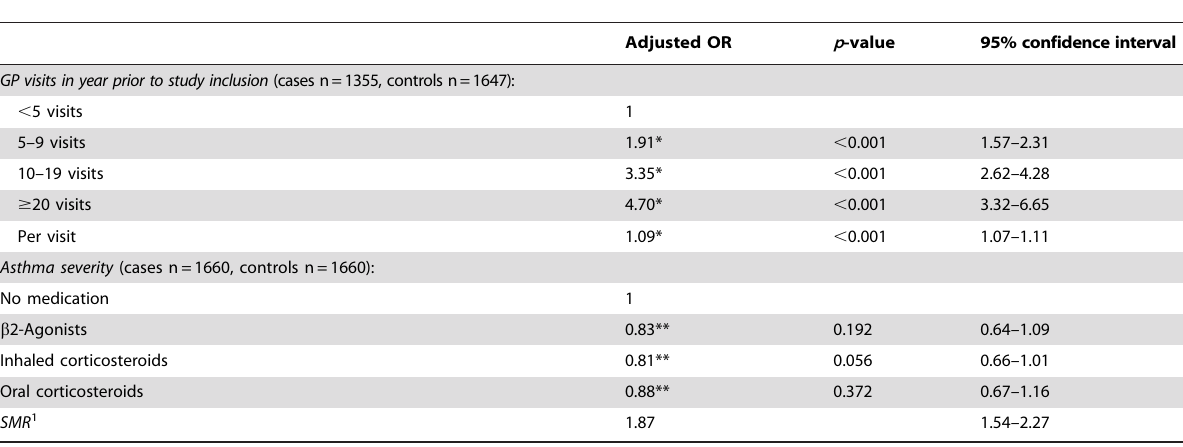
Table 2. Adjusted Odds ratios (OR) for depression in primary care patients with